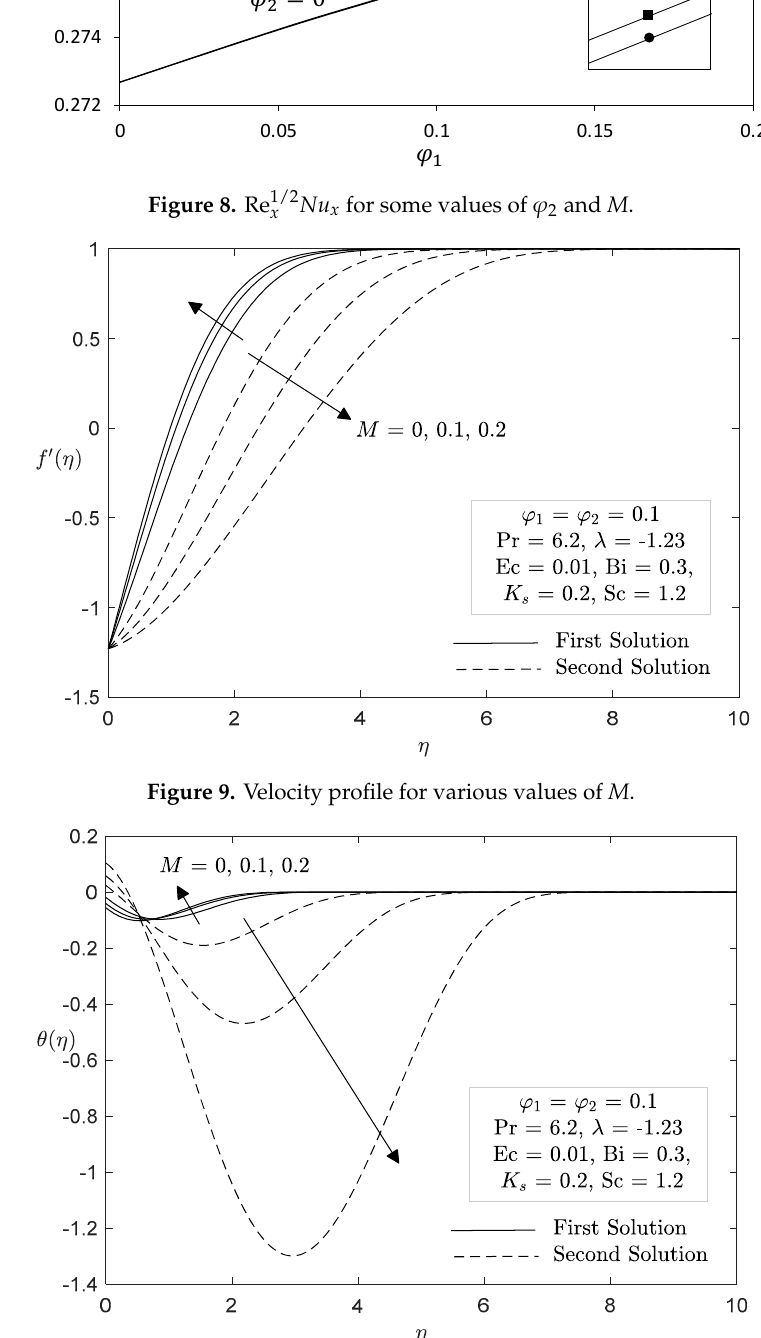
Figure 11. Concentration profile for various values of s K .